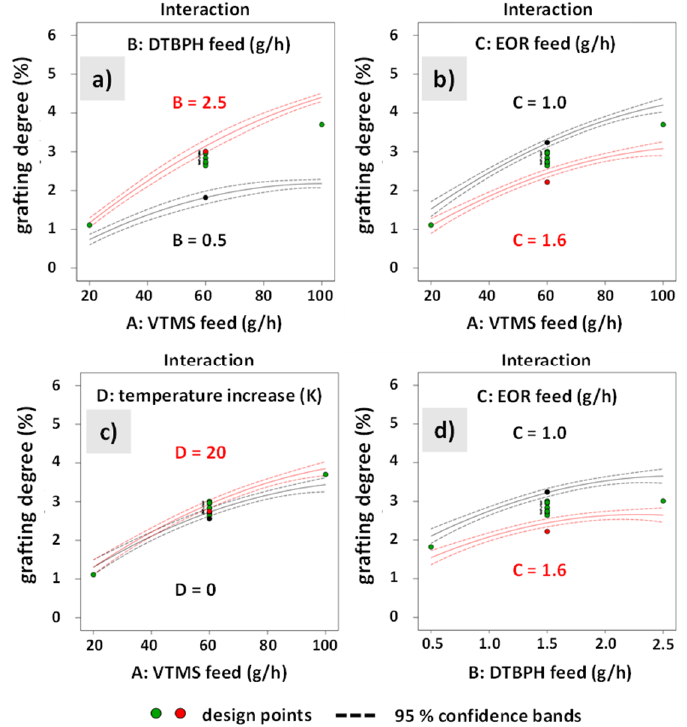
Figure 4. Interaction plots for each relevant interaction on the response grafting degree. The interaction e ff ects shown are the 2 FIAs between: ( a ) VTMS and DTBPH feed rates (AB), ( b ) VTMS and EOC feed rates (AC), ( c ) VTMS feed rate and temperature increase (AD) and ( d ) DTBPH and EOC feed rates.